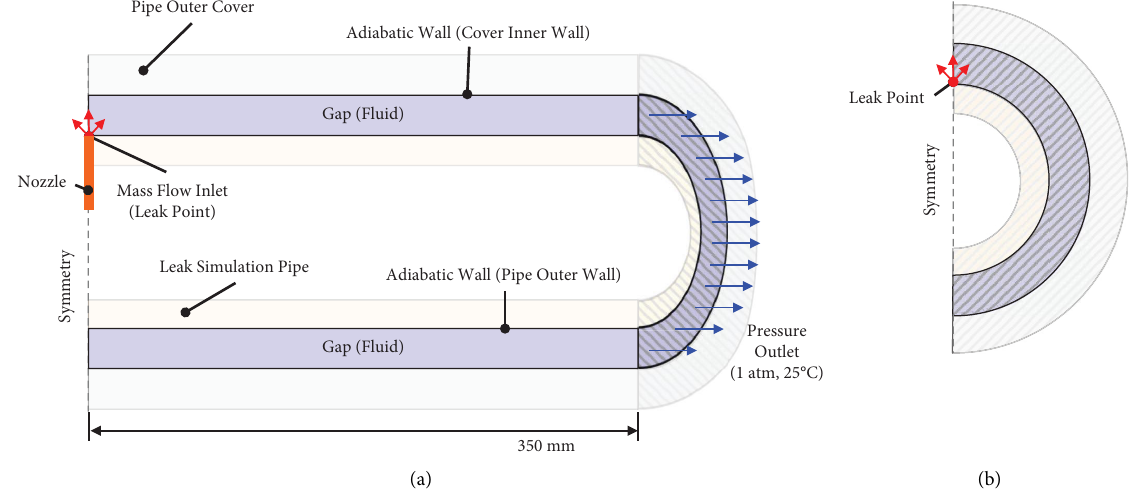
Figure 6: Boundary conditions: (a) front-view and (b)